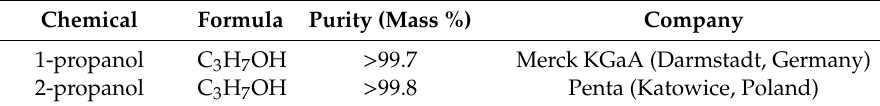
Table 2. Physical properties of experimental materials.